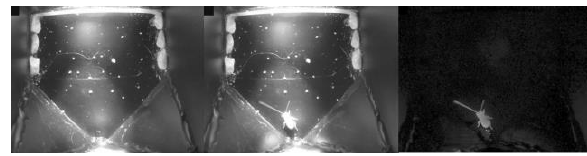
Figure 2. Visual detection of insect in biosensor, showing reference image (left) and the image with a cockroach (centre). Difference between the two images is evaluated as shown on the right part of the figure.